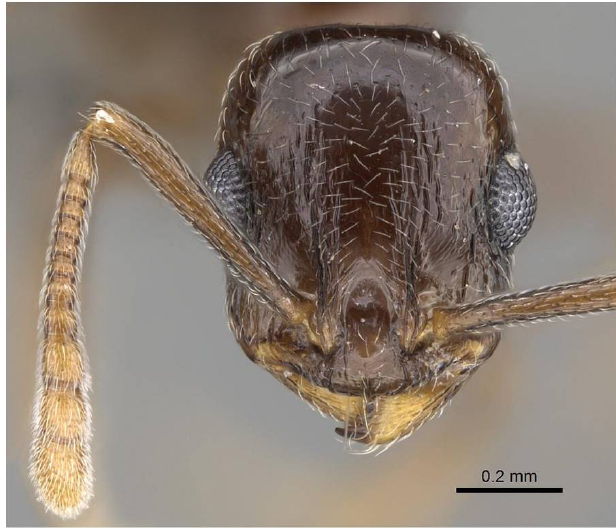
Fig 4 . Head of Temnothorax ansei sp.n. worker in frontal view.